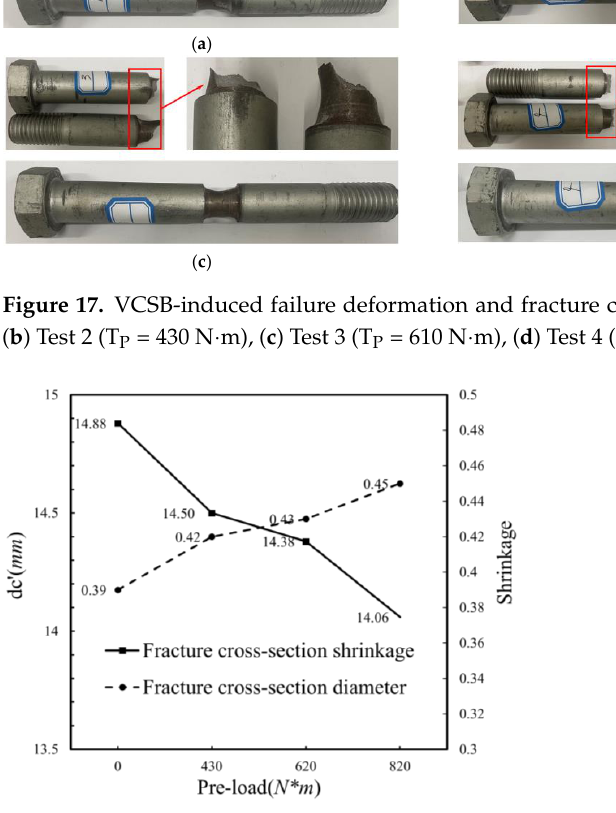
Figure 18. Cross-sectional minimum diameter 𝑑 𝑐′ and sectional shrinkage.